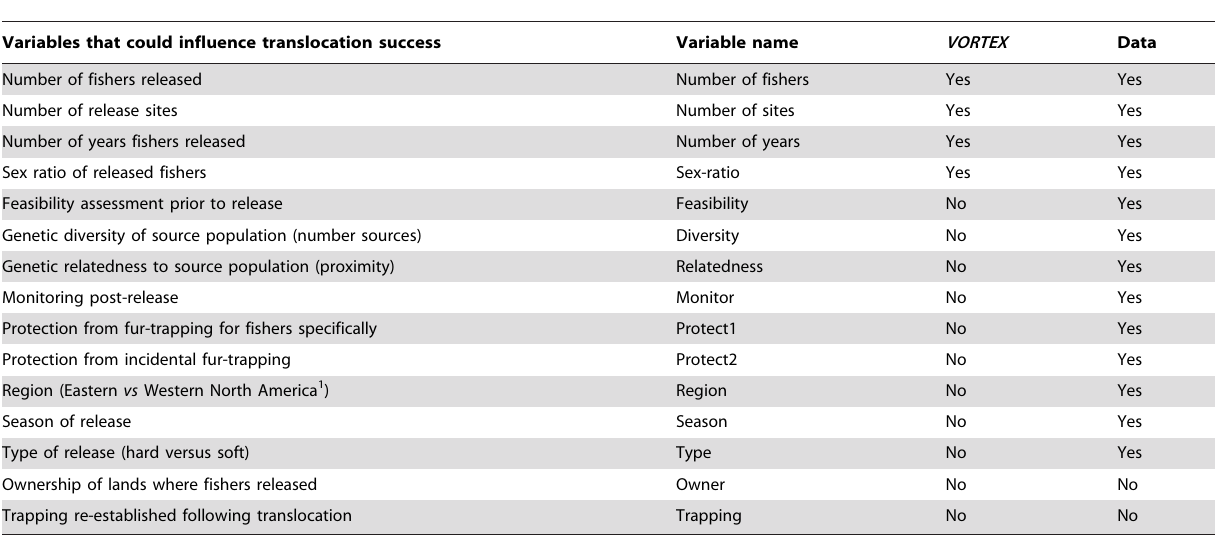
Table 2. General characteristics (variables) of fisher translocations that could influence translocation success.